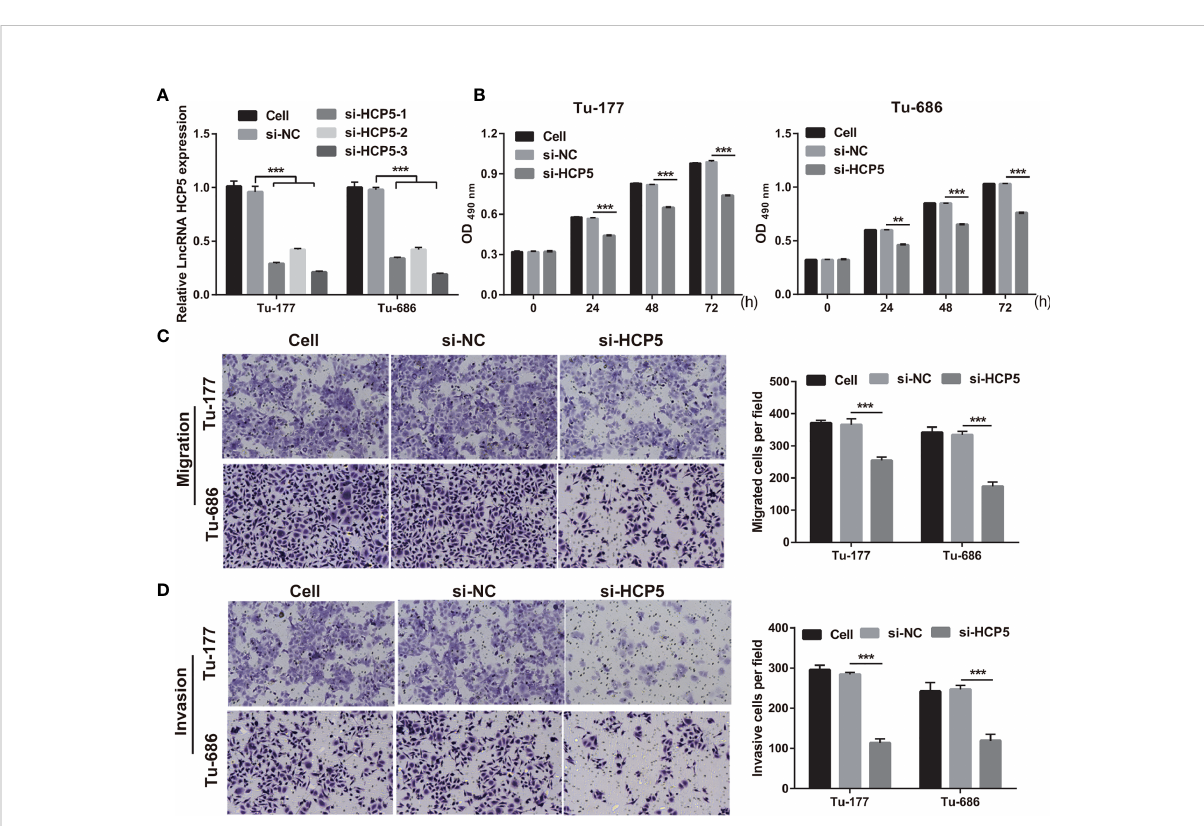
FIGURE 2 Silenced HCP5 inhibited biological behaviors of Tu-177 and Tu-686. (A) HCP5 expression was quanti fi ed by RT-qPCR in Tu-177 and Tu-686 after transfection with si-HCP5 or si-NC. (B) The effect of silenced HCP5 on proliferation in Tu-177 and Tu-686 cells were determined by MTS assay. (C, D) The impact of silenced HCP5 on the migration and invasion of Tu-177 and Tu-686 were tested by Transwell assay (100 × magni fi cation). n =3, ** p < 0.01 and ***p <